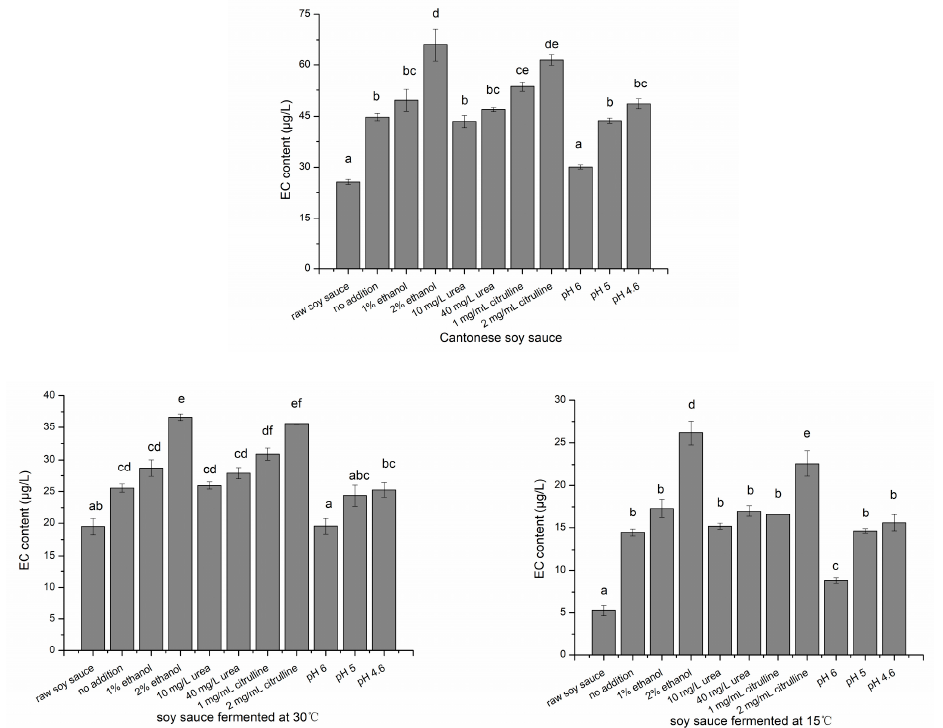
Figure 3. Ethyl carbamate (EC) content of raw soy sauce after heat treatment with possible EC precursors addition and different pH values (bars with different letters are significantly different from the control group ( p < 0.05)).